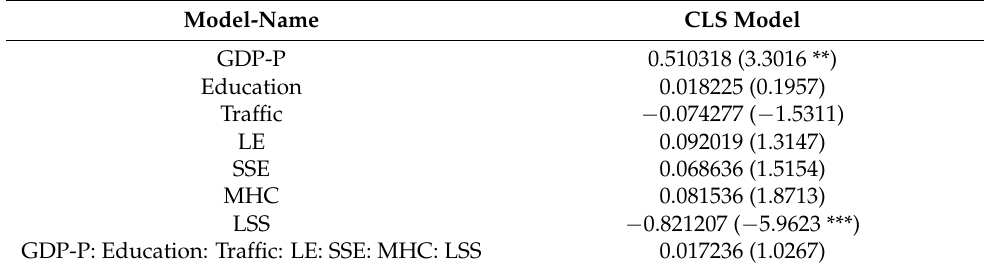
Table 10. Fixed Model results of positive emotions and CLS